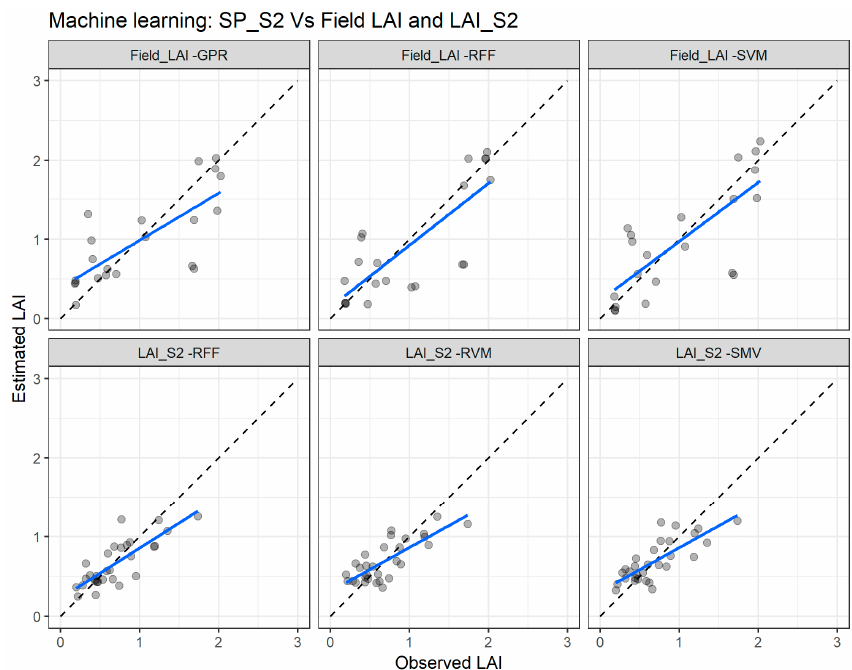
Figure 11. Comparisons of the LAI measured and estimated with the best performing machine learning regression algorithms (MLRA) using the Sentinel-2 spectral data (SP_S2) with the field leaf area index (Field_LAI) and the Sentinel-2 leaf area index product (LAI_S2). GPR—Gaussian process regression; SVM—support vector regression; RFF—random forest Fitensemble; RVM—relevance vector machine. The full line depicts the linear regression and the dashed line the linear regression through the origin.